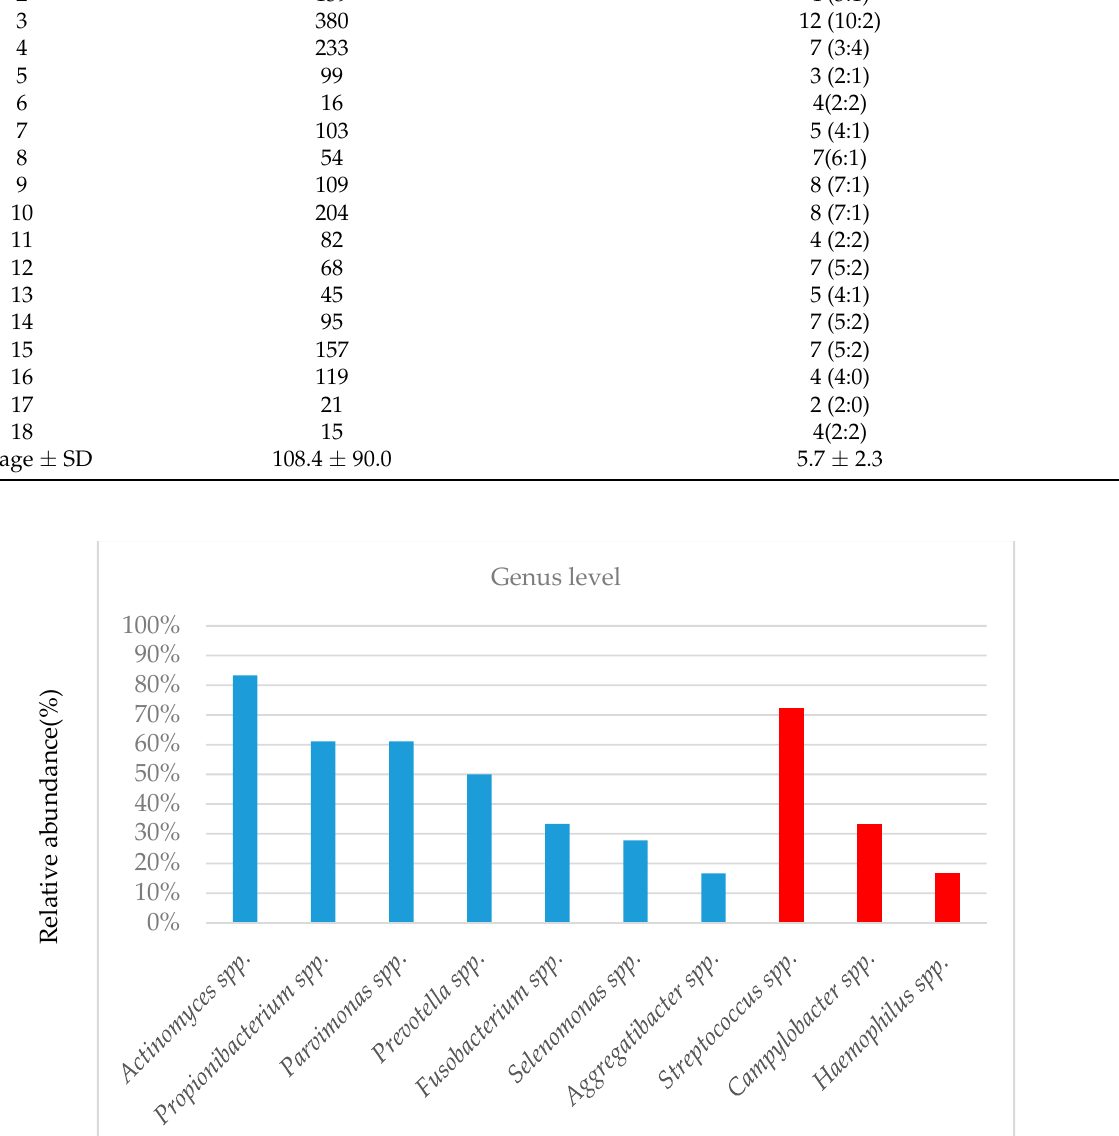
Table 5. The treatment results of canaliculitis. Sample